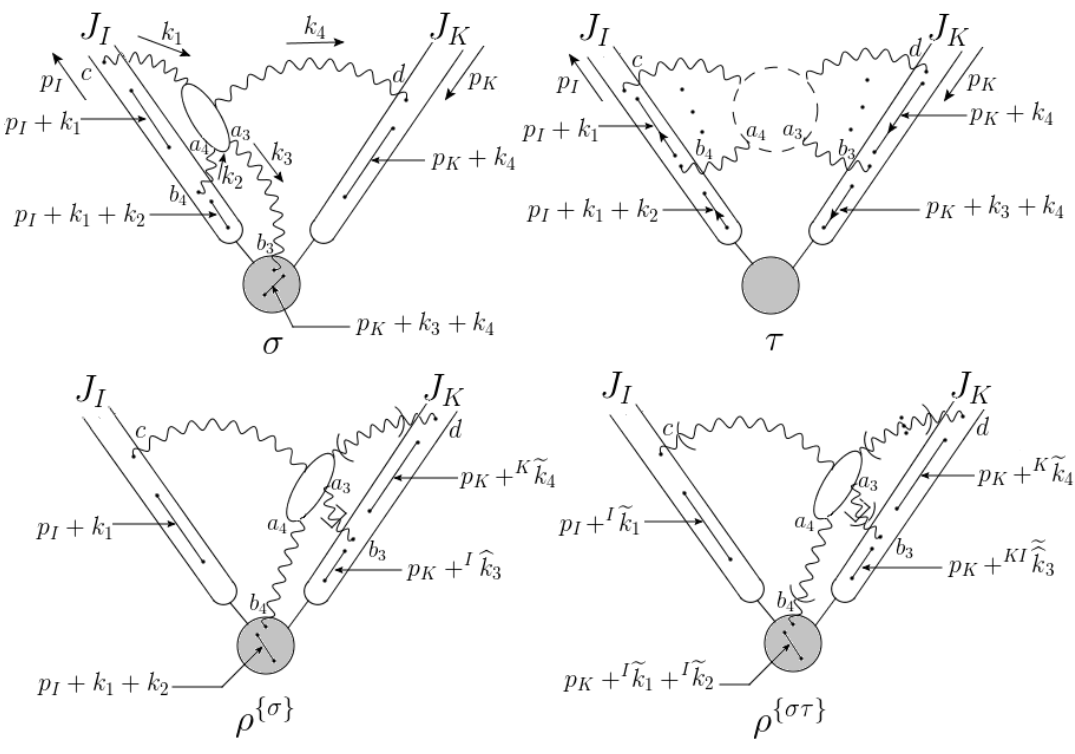
Figure 29. A pictorial illustration of pinch surfaces (cid:27) and (cid:28) of A , (cid:26) f (cid:27) g of t (cid:27) A and (cid:26) f (cid:27)(cid:28) g of t (cid:27) t (cid:28) A , where a 3 b 3 and a 4 b 4 play the role of ab in cases (III) and (IV), respectively. The shaded areas represent the hard subgraphs in each region. The white blob in the middle is parallel to (cid:12) (cid:22) (cid:22) (cid:12) in (cid:26) f (cid:27) g and (cid:26) f (cid:27)(cid:28) g , and is therefore soft in (cid:28) . After we label the four types of momenta attached I the blob by k (cid:22) ( i = 1 ; 2 ; 3 ; 4), all the line momenta in A that contain k i are of the form p I + k 1 , i p I + k 1 + k 2 , p K + k 3 + k 4 and p K + k 4 . Their values change as a result of the